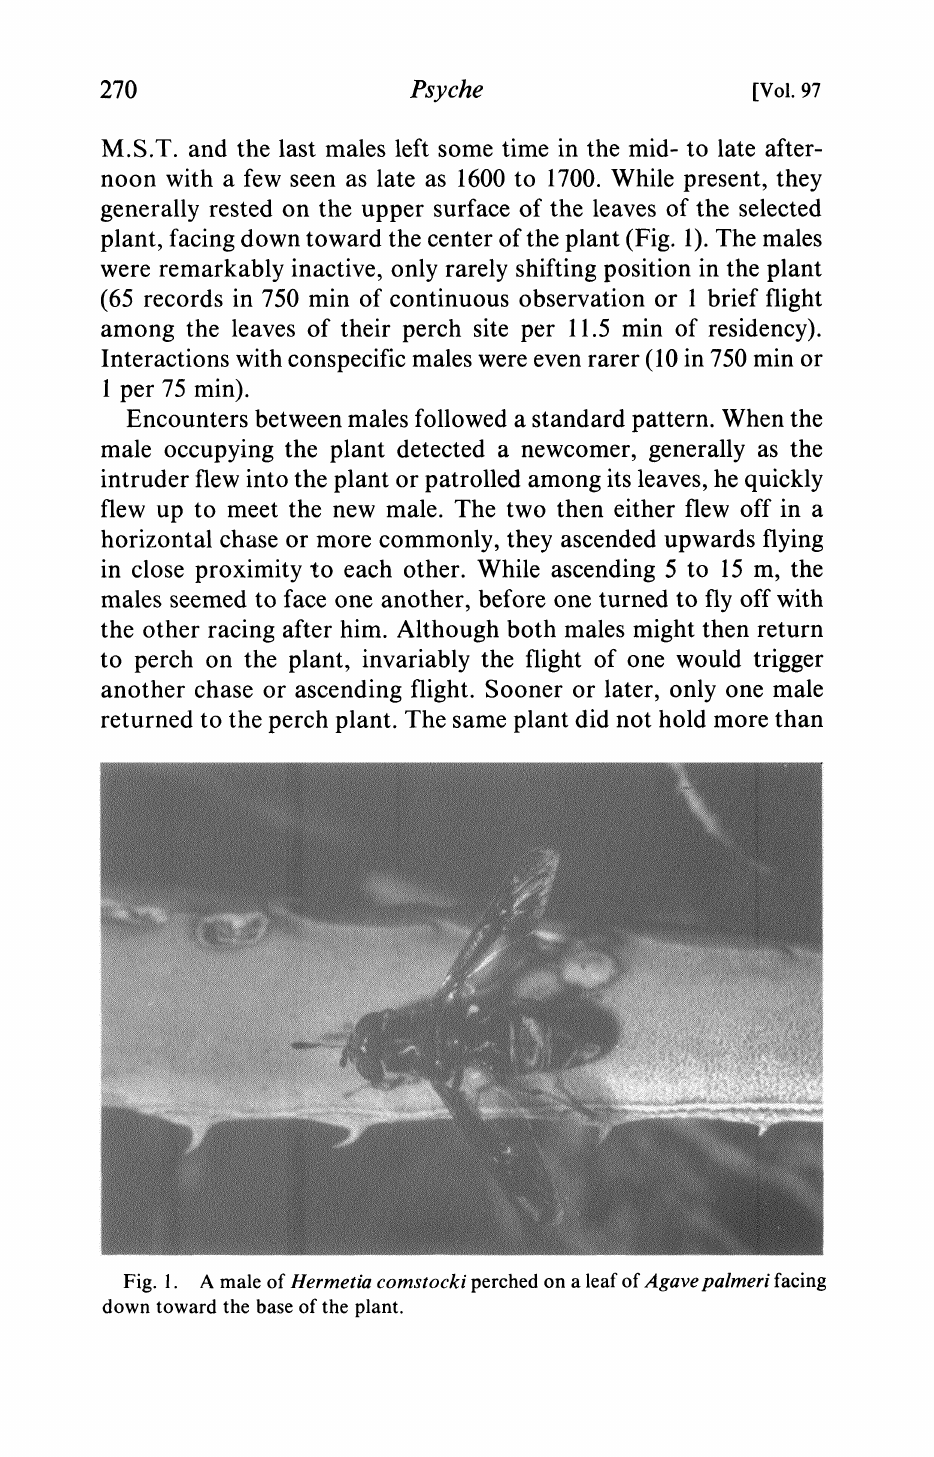
Fig. 1. A male of Hermetia comstocki perched on a leaf of Agavepalmeri facing down toward the base of the